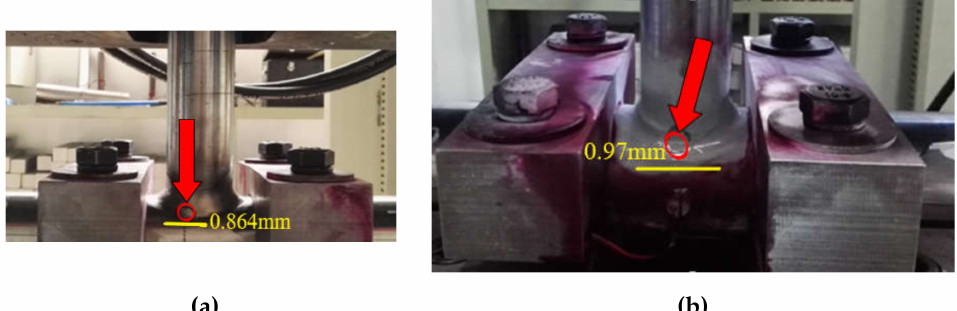
Figure 10. Cracks of T-type tube joint ( a ) observed crack of 0.864 mm length ( b ) observed crack of 0.970 mm length.